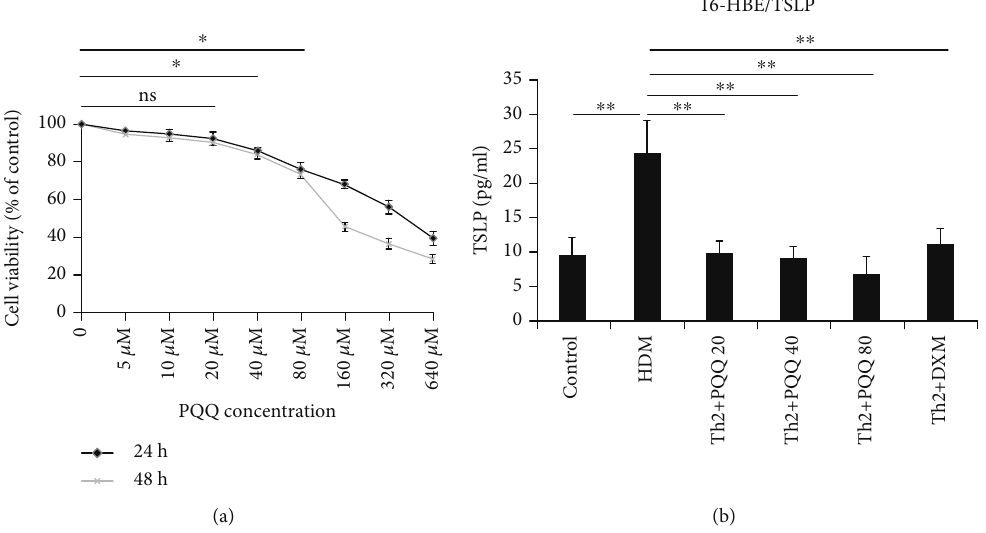
Figure 1: Cell viability and cytokine production in 16-HBE cells treated with di ff erent doses of PQQ. (a) 16-HBE cell viability was reduced after administration of PQQ in a dose-dependent manner. Cell viability was measured by CCK-8 assay after 24h and 48 h of incubation with PQQ. (b) Cytokine production by 16-HBE cells after 2h of pretreatment with PQQ and subsequent incubation with HDMs. The columns and error bars represent the means and SEMs ( n = 3 per group). ∗ P < 0 : 05 , ∗∗ P < 0 : 01 ; ns: not statistically signi fi cant. Similar results were obtained in three independent experiments.